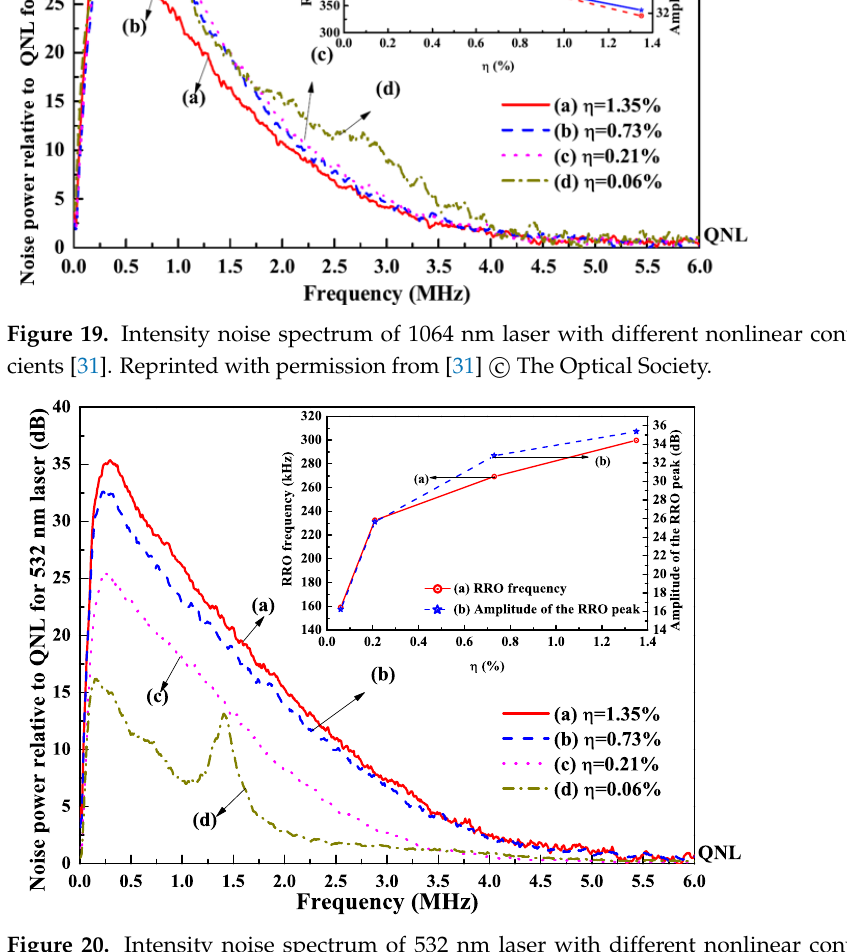
Figure 20. Intensity noise spectrum of 532 nm laser with different nonlinear conversion coeffi- cients [31]. Reprinted with permission from [31] c (cid:13) The Optical